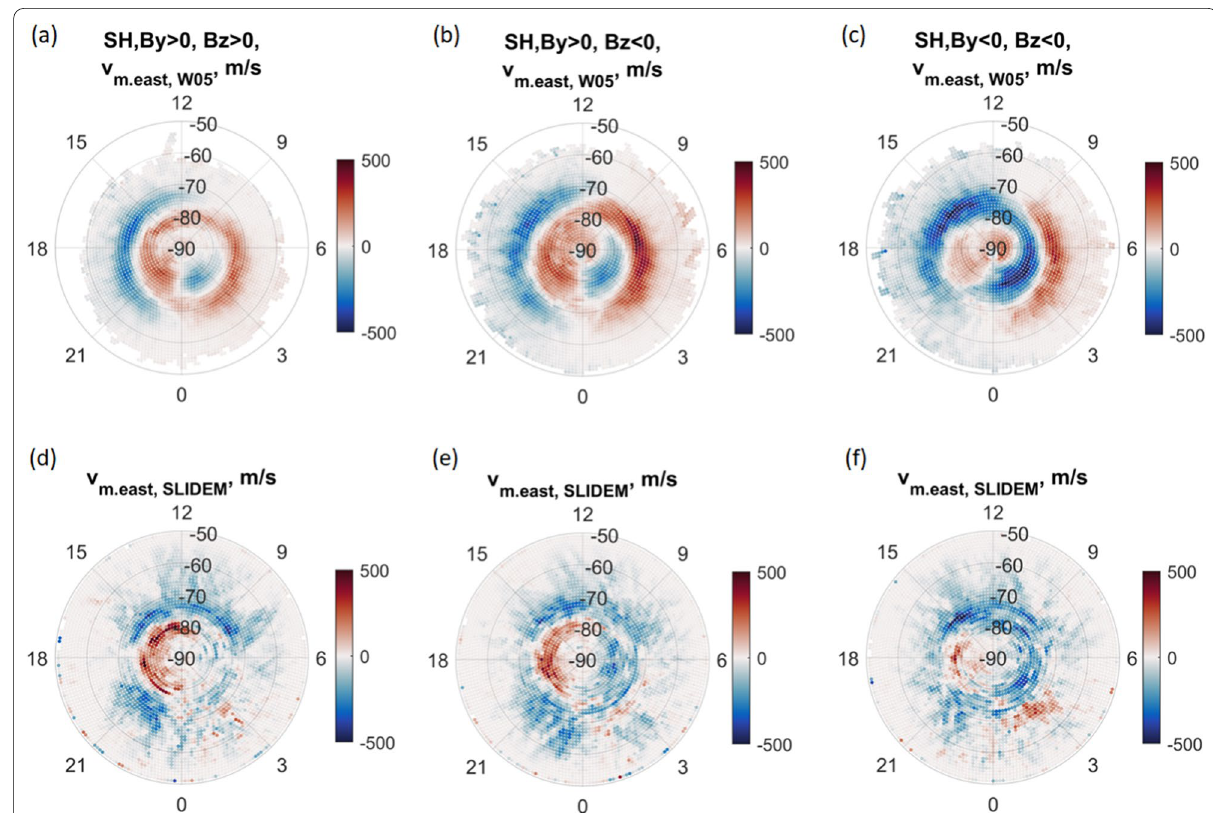
Fig. 8 Magnetic latitude-local time maps for Swarm A magnetic eastward ion drift components obtained from along-track data for different IMF conditions in the southern hemisphere. Northward IMF B z , positive IMF B y results are shown in a for Weimer (2005) and in d for SLIDEM. For southward IMF B z and positive IMF B y , Weimer 2005 is shown in b while SLIDEM is shown in ( e ). The case of southward IMF B z and negative IMF By is shown in c for Weimer (2005) and in f for